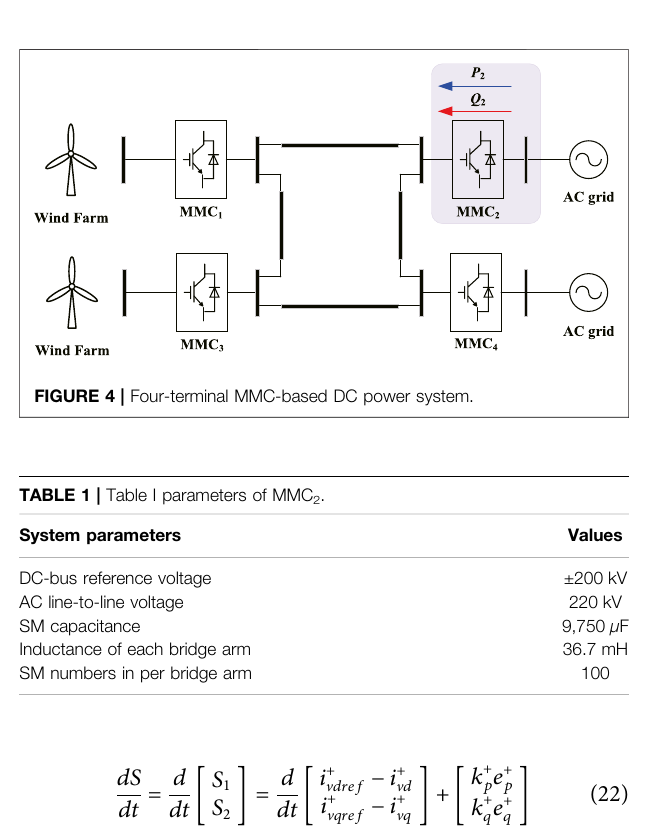
FIGURE 3 | Control diagram of the proposed ISMVC for MMC.